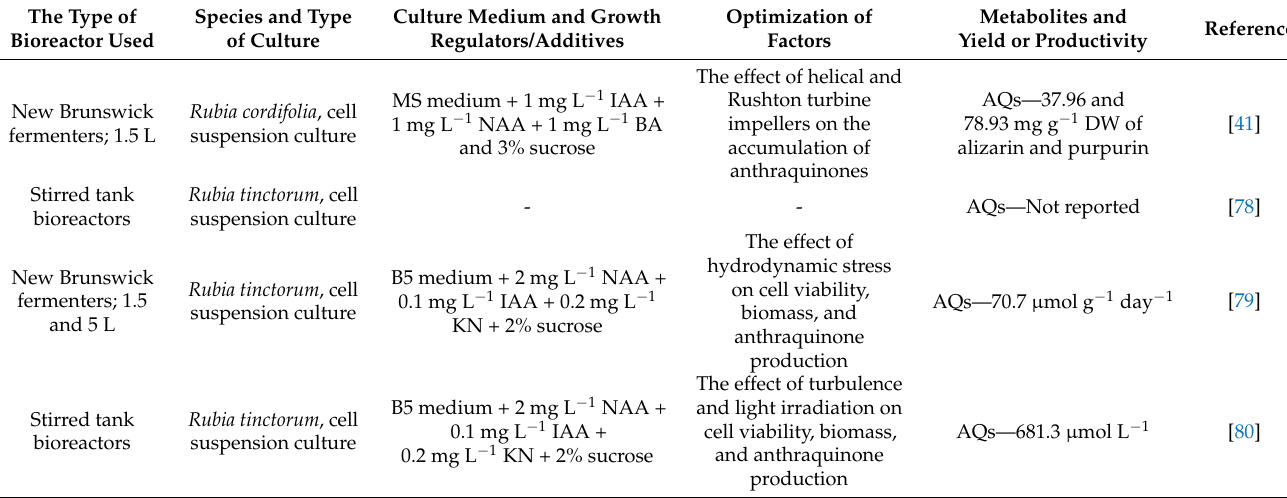
Table 5. Production of AQs in Rubia species using bioreactor